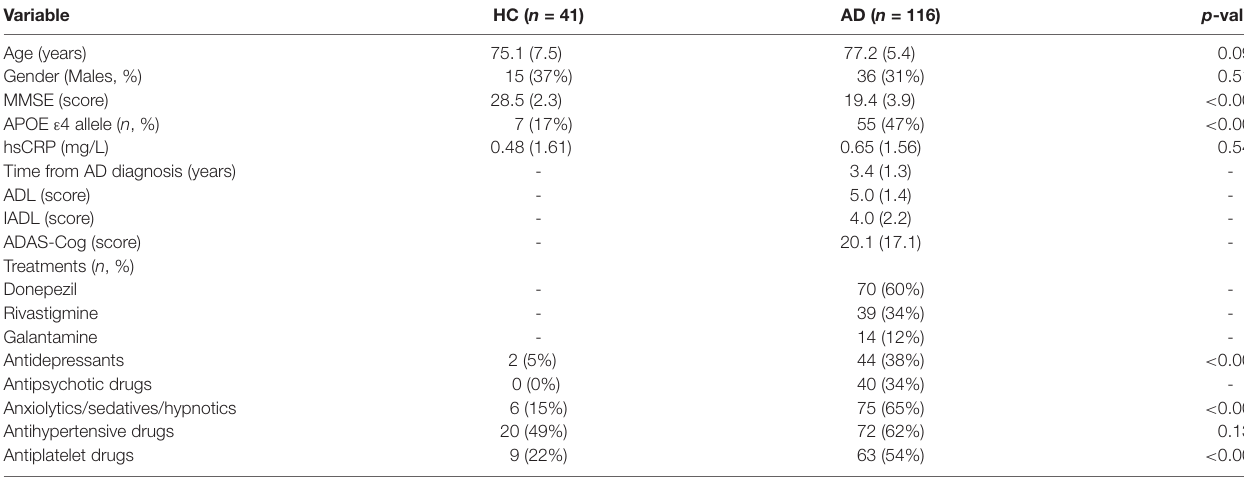
TABLE 1 | Clinical and demographic characteristics of healthy control subjects (HC) and patients with Alzheimer’s disease